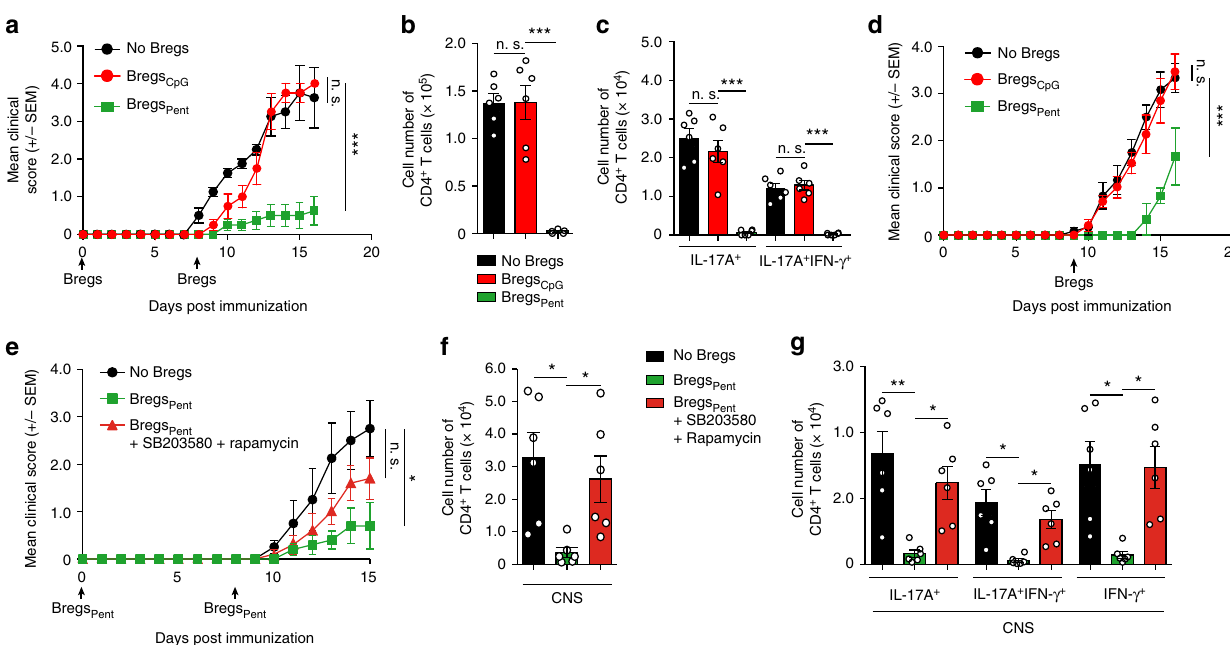
Fig. 6 Pentanoate-treated Bregs protect mice from EAE development. a – g EAE development in mice in the presence or absence of pentanoate-induced Bregs. For induction of EAE, FIR × tiger mice were immunized with MOG peptide. A control group of Bregs (Bregs CpG ) was treated with vehicle (water). Pentanoate-treated Bregs (Bregs Pent ) were generated in the absence or presence of rapamycin (100 nM) and SB203580 (5 μ M). Mice received 2 × 10 6 sorted GFP + Bregs on day 0 and day 8 ( a – c and e – g ) or only on day 8 ( d ) post immunization ( n = 6 mice per group from one representative experiment of two). Mice were monitored daily for EAE progression. Total cell number of pathogenic CD4 + T lymphocytes in the CNS on day 17( a , d ) or day 15 ( e ) after EAE development was analyzed by fl ow cytometry. Black arrows indicate the day of administration of Bregs ( a , d ). Error bars indicate SEM, n.s. = not signi fi cant; * P < 0.05; ** P < 0.01, *** P < 0.001 (one-way ANOVA